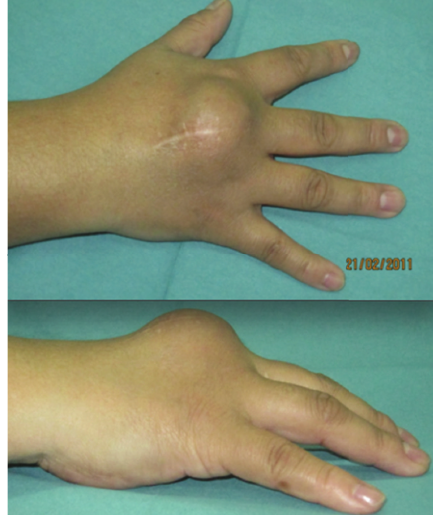
Figure 3: Clinical presentation of the local tumor recurrence in the dorsal